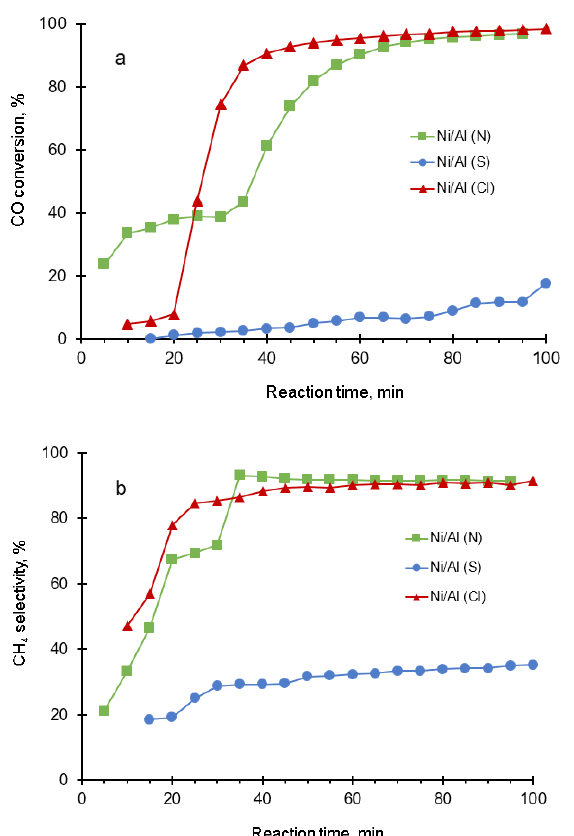
Table 2. Sulfur contents in the obtained catalysts of